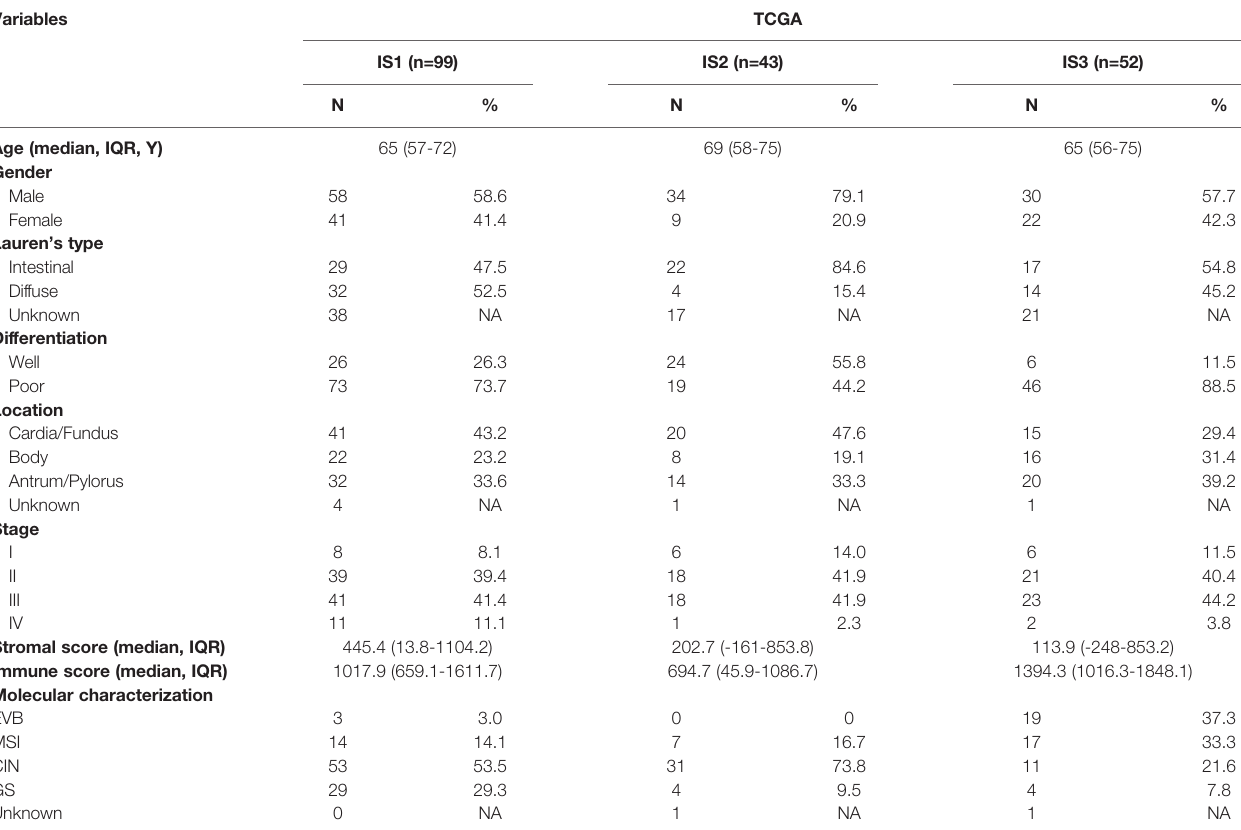
TABLE 2 | Clinicopathological characteristics of patients with gastric cancer in TCGA. Variables